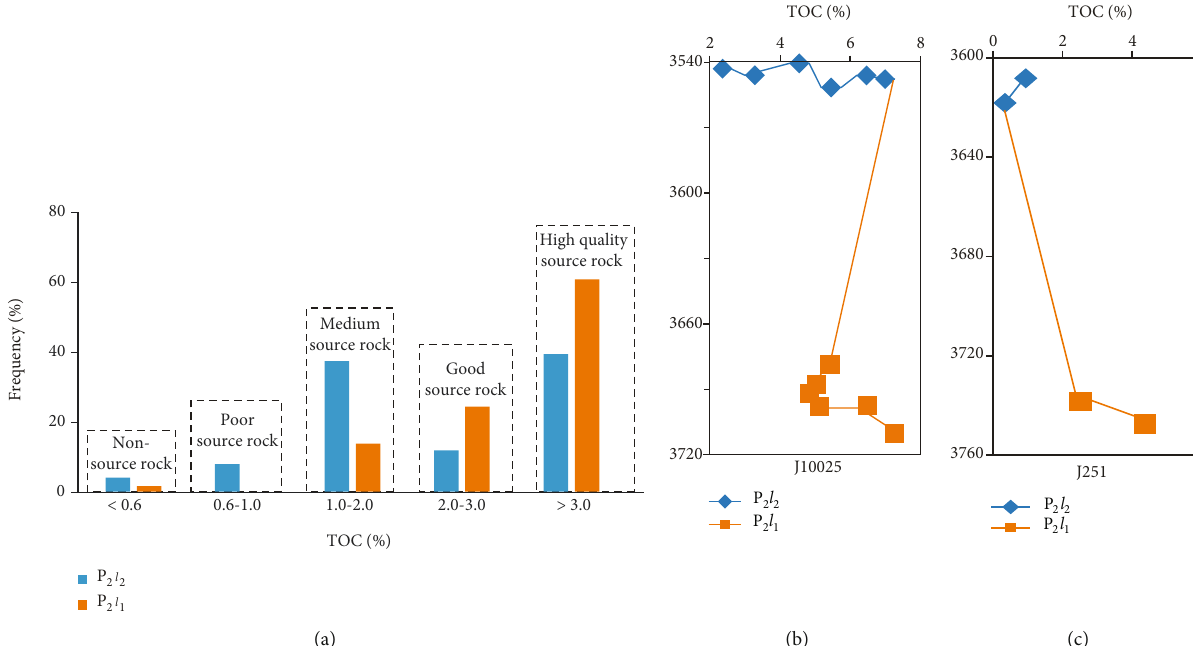
Figure 11: Total organic carbon content characteristics of source rocks in Lucaogou Formation, Jimsar Sag (a). Distribution characteristics of organic matter in the upper and lower sweet spots of single wells J10025 and J251 (b) and (c), respectively.